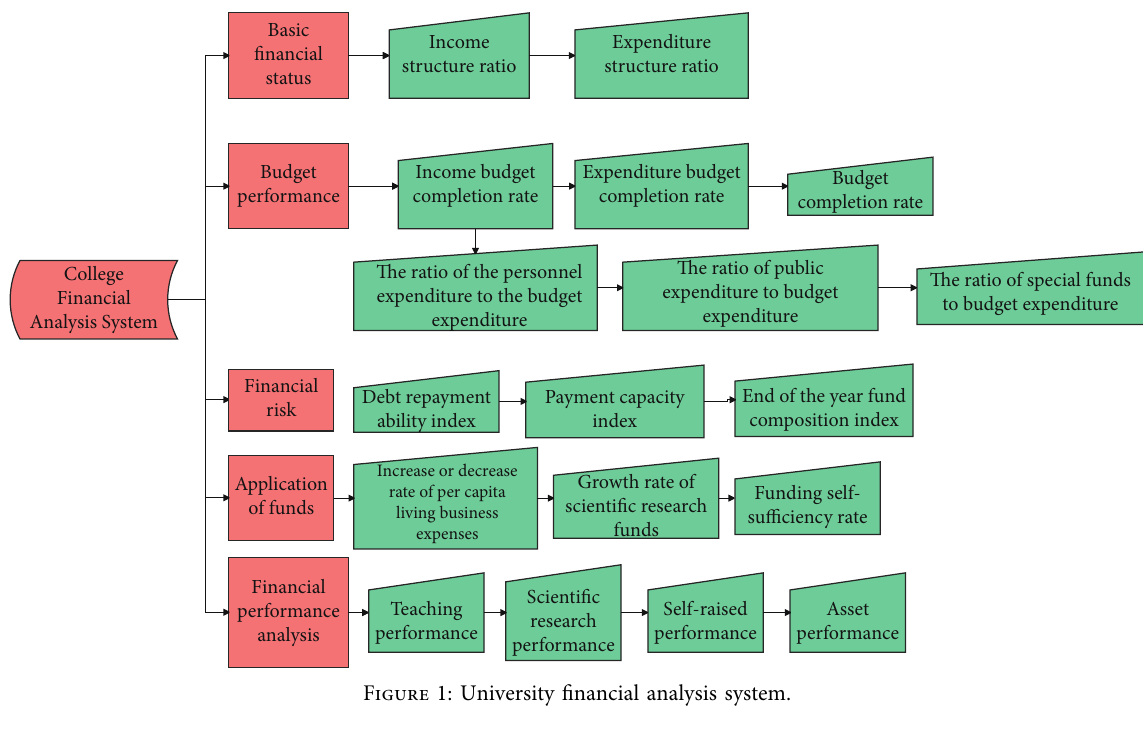
Figure 1: University financial analysis